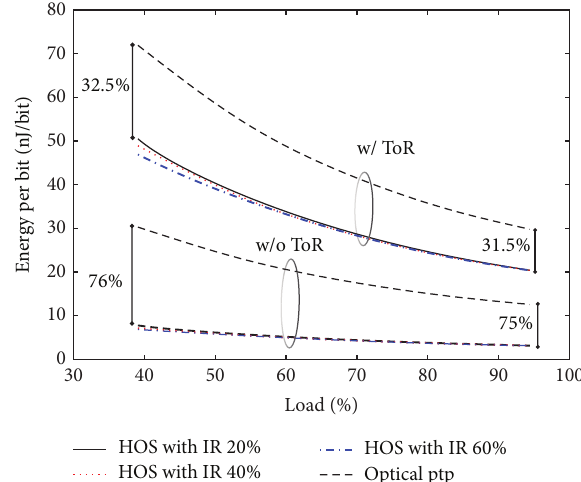
Figure 10: Energy consumption per bit of successfully transmitted data for the HOS and optical ptp networks. Both the cases with and without the ToR switches are